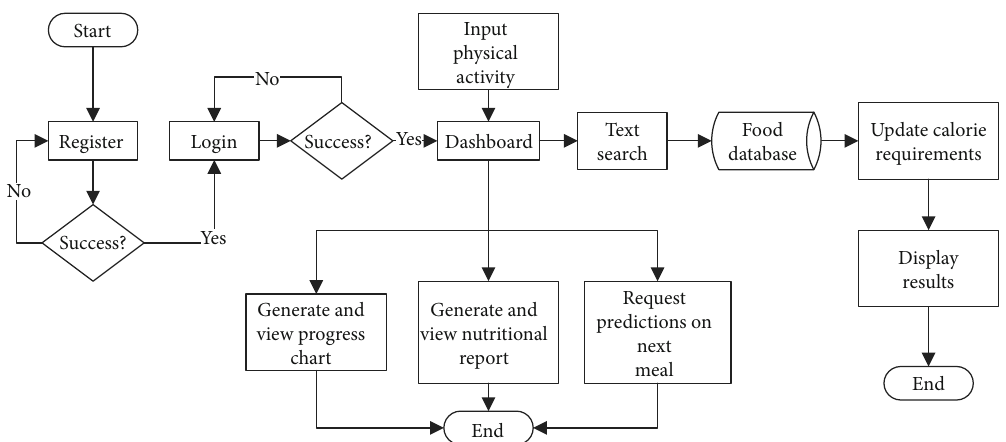
Figure 5: Operational fl ow diagram for the obesity management system.